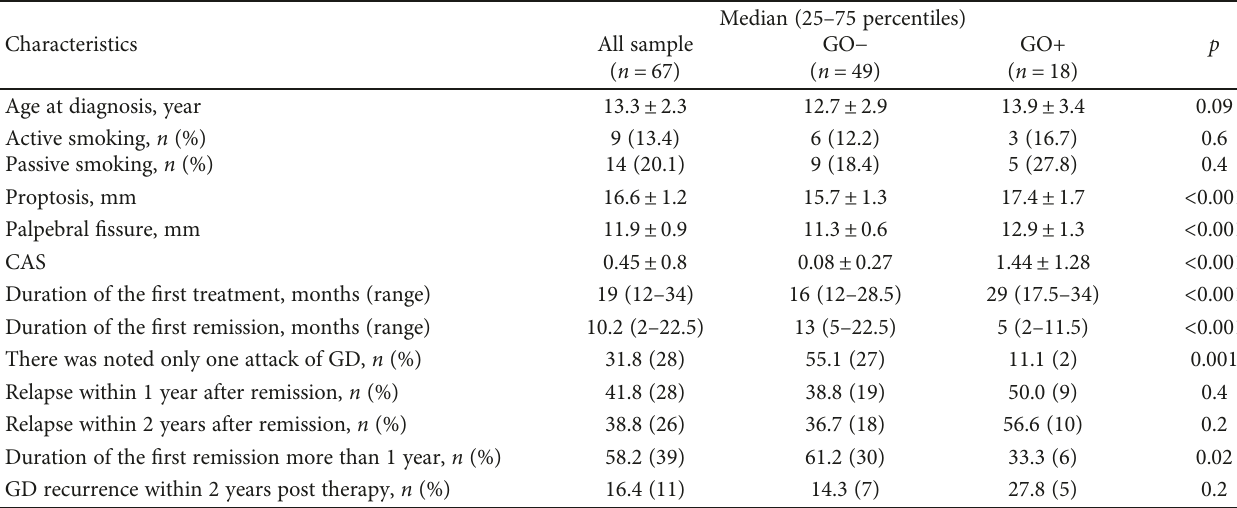
Table 1: Characteristics of patients with